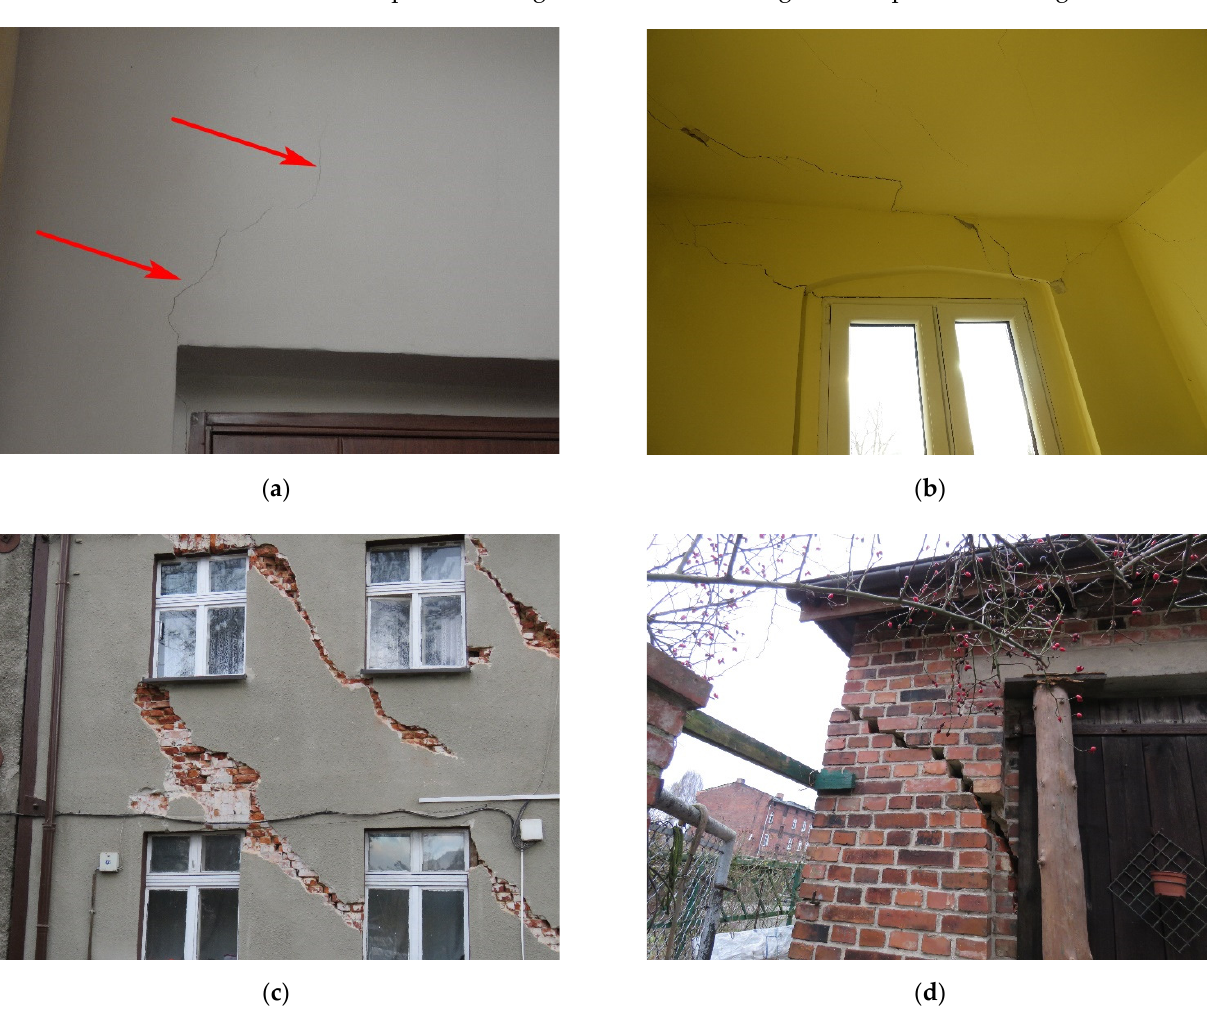
Figure 19. Examples of damages in a building classified as: ( a ) damage category 1; ( b ) damage category 2; ( c ) damage category 3; ( d ) damage category 4.